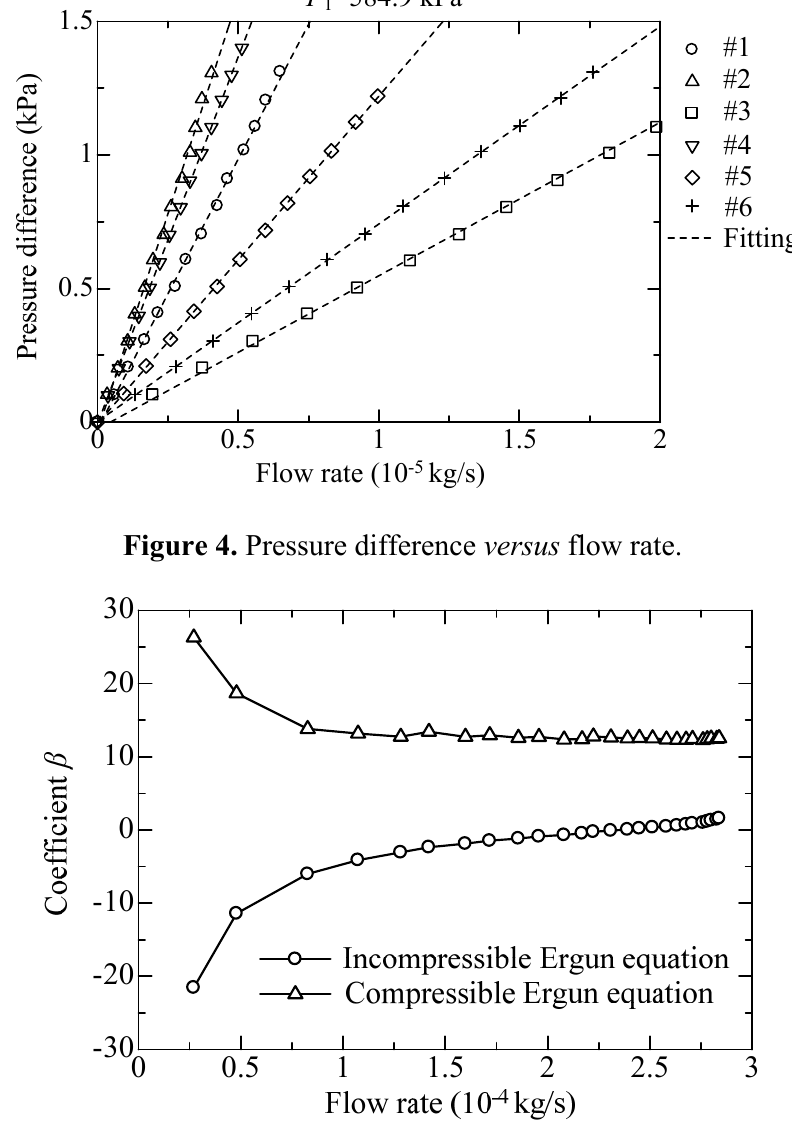
Figure 5. Coefficient β versus flow rate (resistance